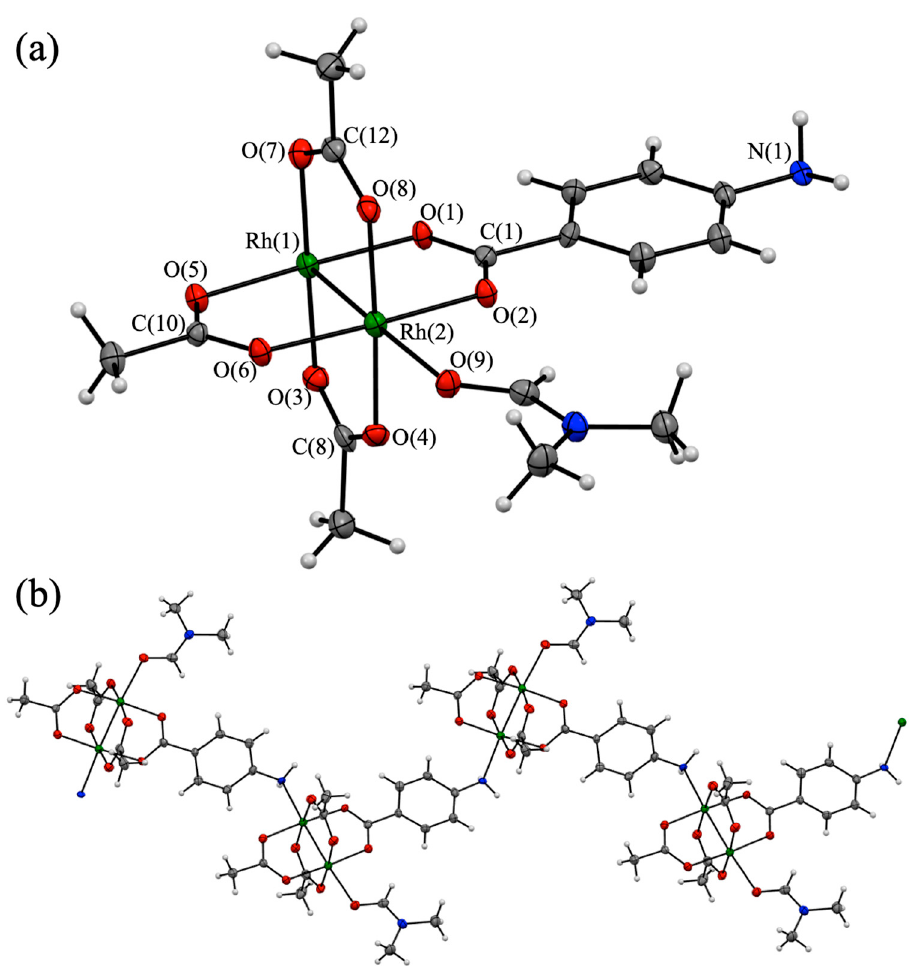
Figure 2. ( a ) Asymmetric unit of [Rh 2 (O 2 CCH 3 ) 3 (PABC)(DMF)] n ( 1P ) (30% thermal